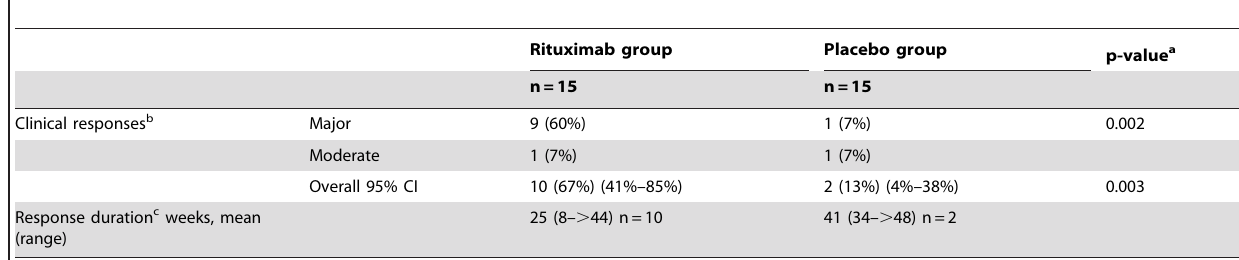
Table 3. Clinical responses in the Rituximab and Placebo groups, and response durations for patients with significant responses, derived from self-reported Fatigue scores during 12 months